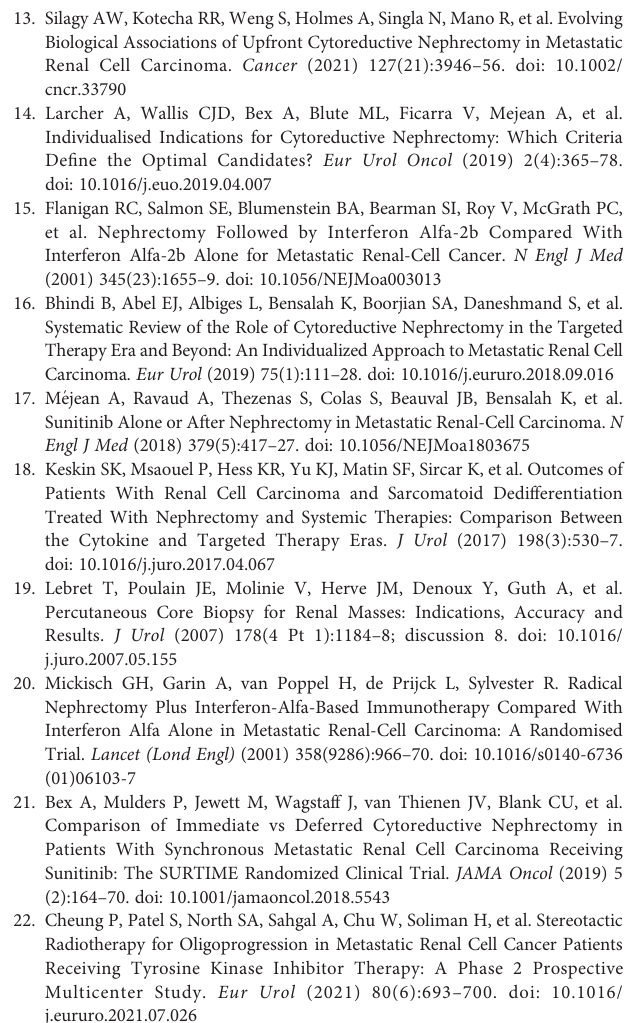
Supplementary Figure 1 | Venn diagram of metastatic site in overall patients. Supplementary Figure 2 | Kaplan – Meier analysis of the number of metastases in the overall surgery